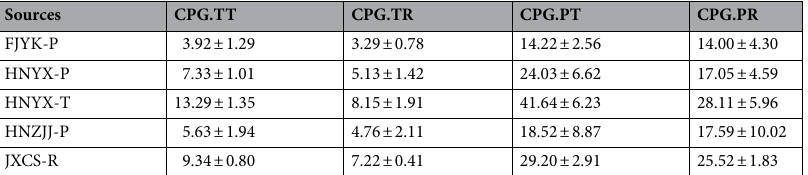
Table 4. The statistical analysis of wood mechanical properties of Chinese fir. Data are means ± SE. CPG. TT compression strength perpendicular to the grain (total tensile) (MPa), CPG.TR compression strength perpendicular to the grain (total radial) (MPa), CPG.PT compression strength perpendicular to the grain (part tensile) (MPa), CPG.PR compression strength perpendicular to the grain (part radial) (MPa).